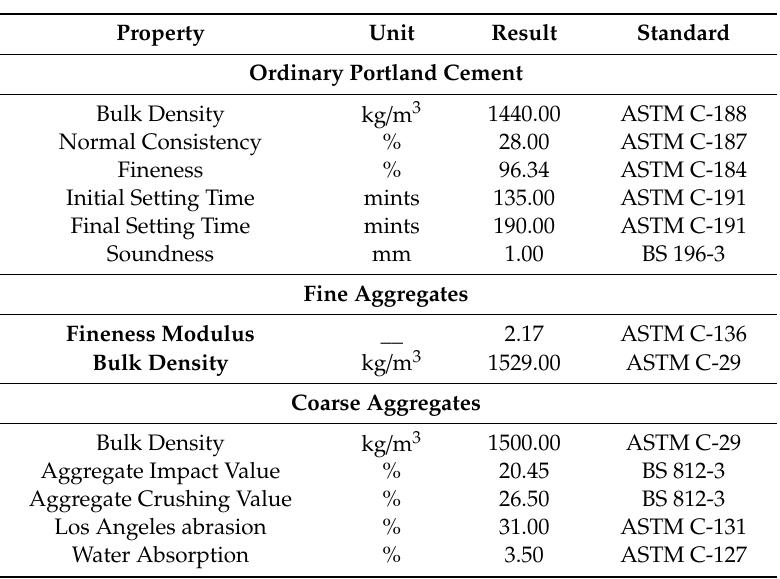
Table 2. Basic physical properties of the